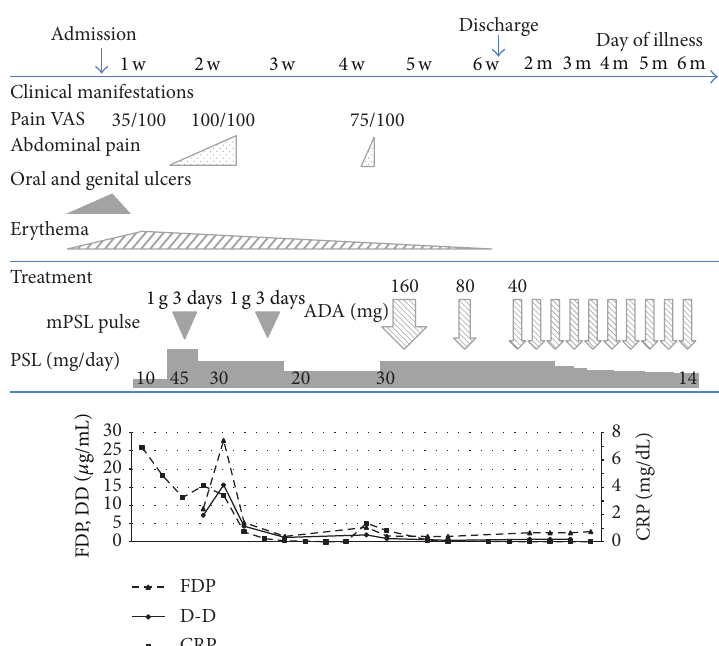
Figure 4: Clinical course of the patient. Corticosteroid pulse therapy with methylprednisolone was administered to the patient. After two coursesofcorticosteroidpulsetherapy,thesymptomsandbloodtestresultsshowedimprovement.Theabdominalpainrelapsedwhiletapering the dose of corticosteroid. The patient was begun on adalimumab at a dose of 160mg in week 0, 80mg in week 2, and 40mg every other week thereafter. The clinical manifestations of Behcet’s disease resolved soon after the initiation of